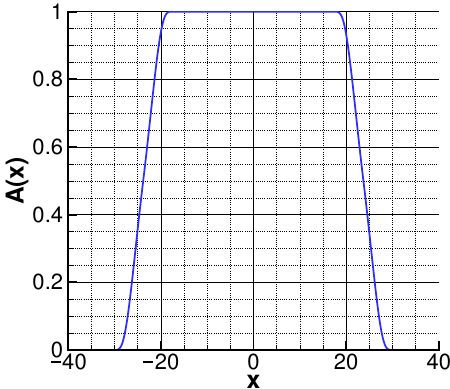
Figure 1. Signal